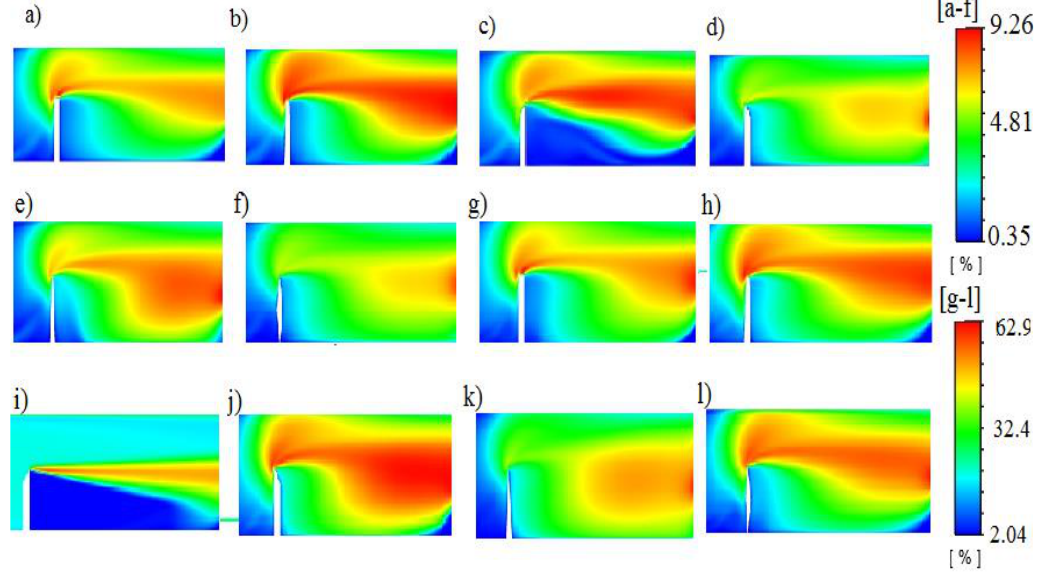
Figure 6. Profiles of TE for at Re = 20, 000 [a-f] and at Re = 1, 00, 000